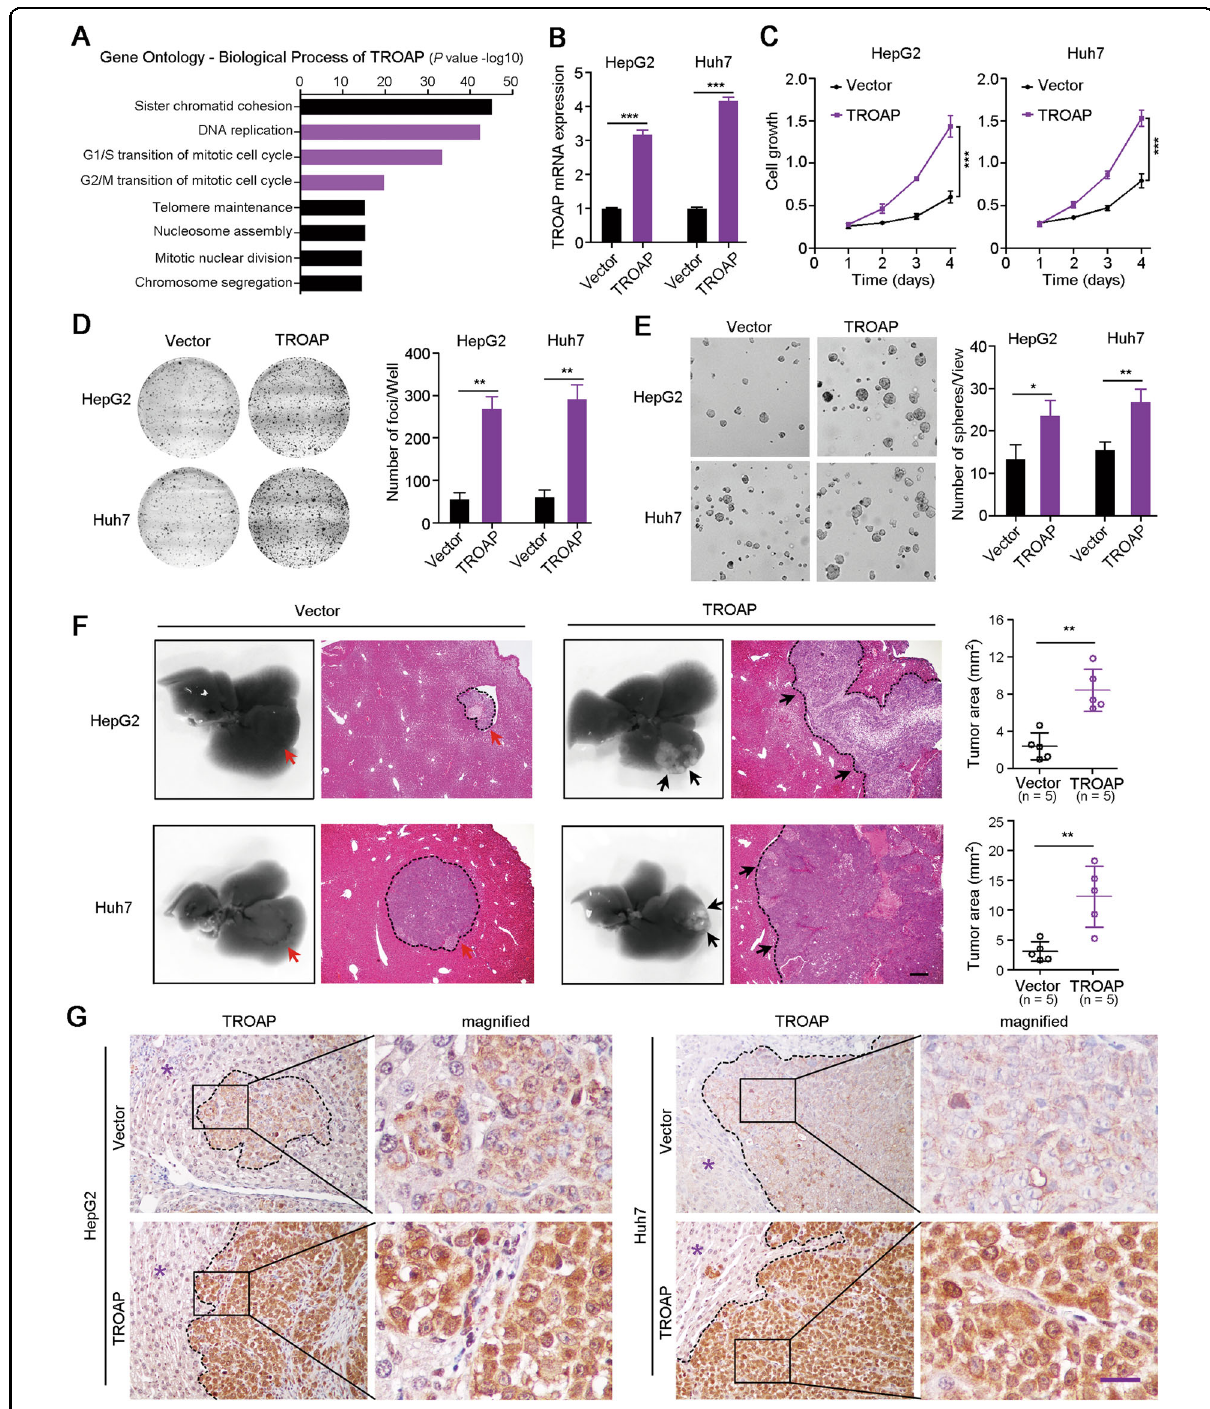
Fig. 2 Overexpression of TROAP promotes HCC cell growth in vitro and in vivo. A Gene Ontology (biological process) analysis of TROAP in human using Coexpedia internet tool (http://www.coexpedia.org/). B Overexpression of TROAP was con fi rmed with RT-qRCR assay in HepG2 and Huh7 cells after lentivirus-mediated transfection of TROAP. Cell growth curves ( C ), foci formation ( D ), and sphere formation ( E ) assays were used to investigate the activity of TROAP in HCC cells, respectively. F Orhtotopic liver transplantation of HCC cells after overexpression of TROAP in nude mice. Xenograft nodes were indicated by arrows. Tumor area was analyzed with ImageJ software and summarized in right panel. G IHC staining con fi rmed the high expression of TROAP in xenograft tumors derived from TROAP-overexpressed HCC cells. Asterisk, normal liver tissue; Scale bar, 50 μ m. In panels B – F , data are represented as mean ± SD; two-sided Student ’ s t -test; * P < 0.05; ** P < 0.01; *** P <